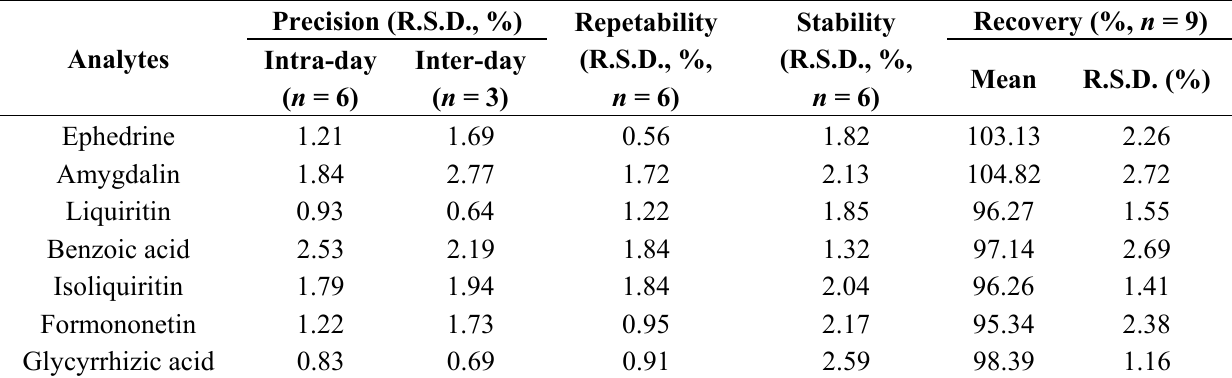
Table 3. Precision, repeatability stability and recovery of the seven analytes. Analytes